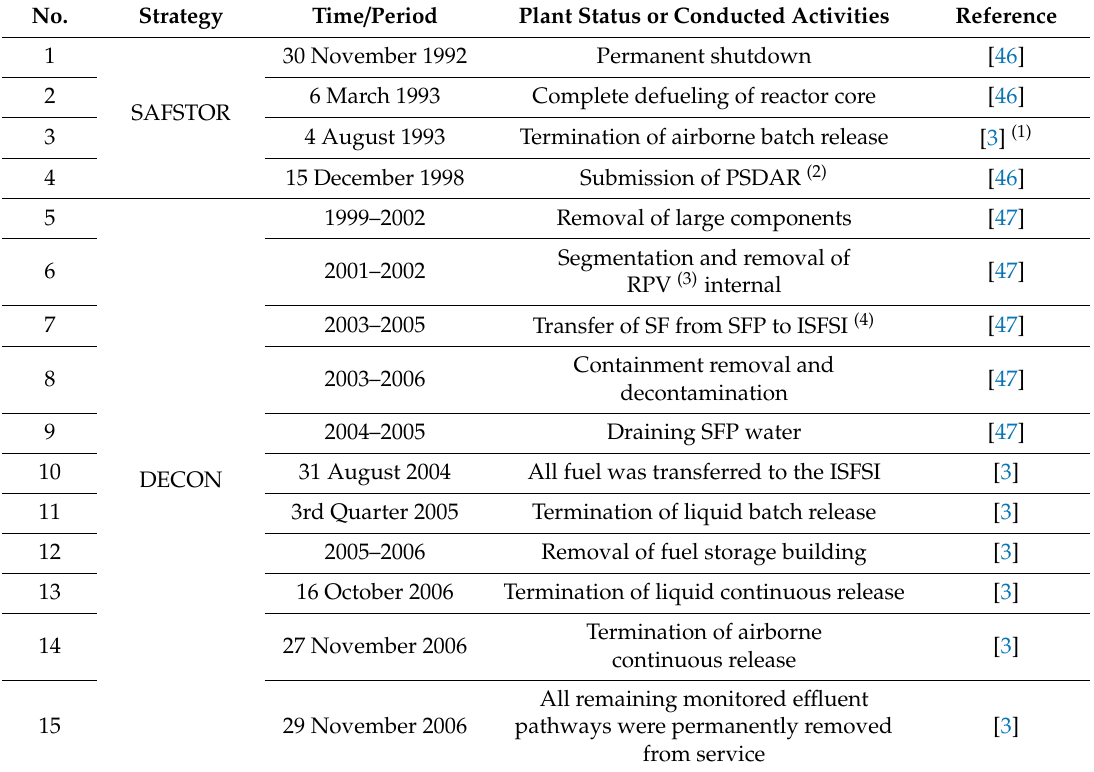
Table 5. Main events or activities of San Onofre-1 from permanent shutdown to termination of its e ffl uent monitoring